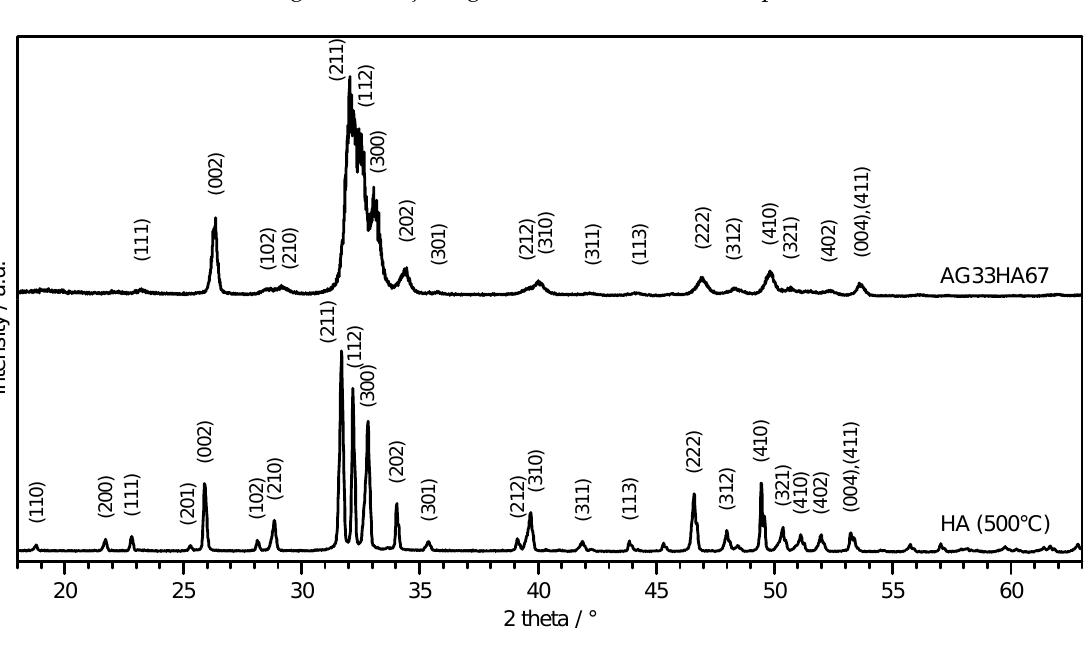
Figure 1. X-ray diffraction of hydroxyapatite (HA) dried at 500 ◦ C and lyophilized agarose/HA composite